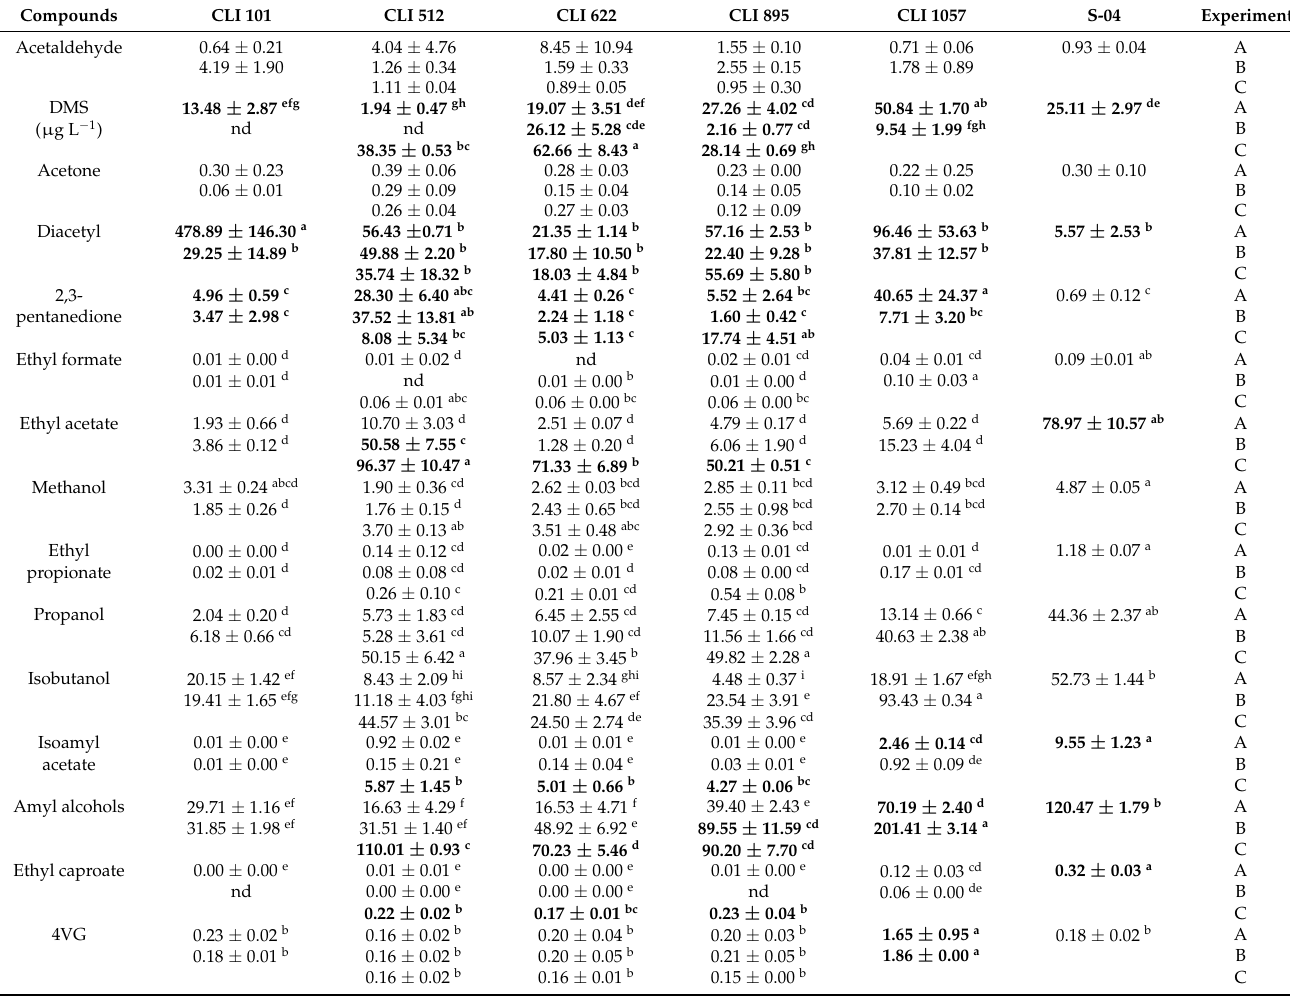
Table 3. The main volatile compounds in the beer are produced by the different yeast strains (mg L − 1 ) under different experimental conditions (A, B,